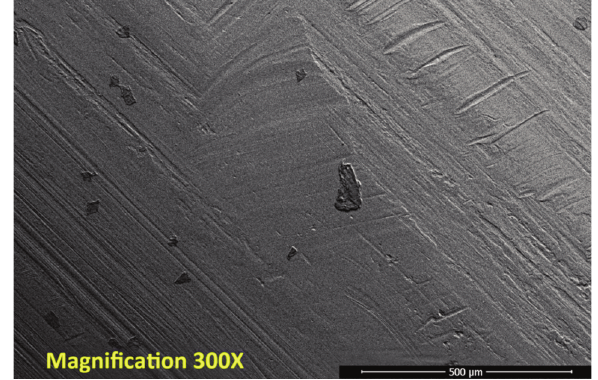
SEM image from inferior ridge of the FNE from Patient 1 Fig. 4: with medial migration. On higher powered magnification (300x), more transverse scratch marks can be seen at closer intervals with varying depths.